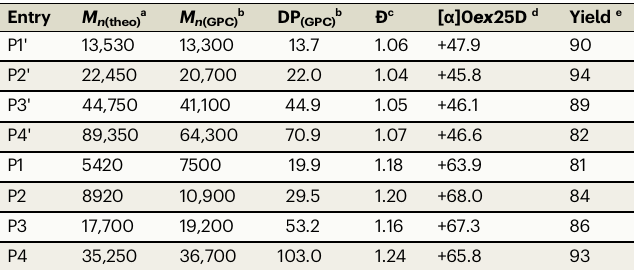
Table 1 | Polymer Characterization using GPC, NMR, and Optical Rotation